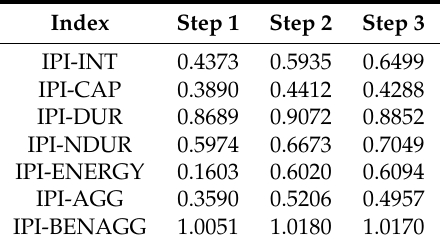
Table 20. Comparison of the ratio between mean absolute errors with an expanding window from 2015:01 to 2018:12.